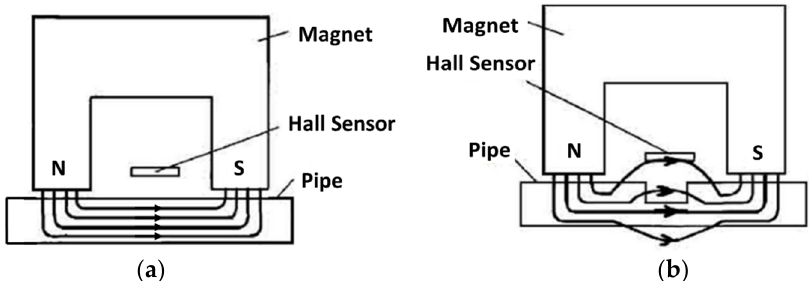
Figure 6. Principle of the magnetic flux leakage (MFL) method: ( a ) Magnetic flux lines mostly pass through the inside of ferromagnetic materials without defects, and ( b ) the Hall-effect sensor can detect the magnetic flux leakage when pipes have defects [41].